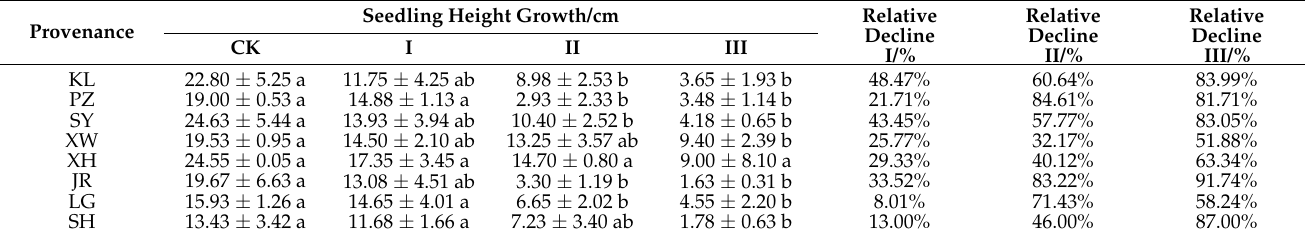
Table 2. The seedling height growth of Melia azedarach among different provenances under drought stress.